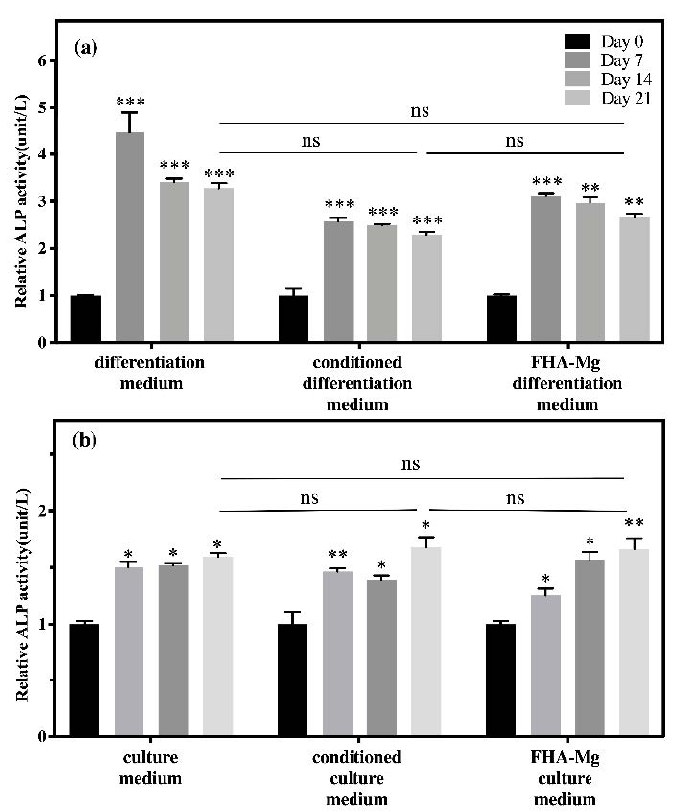
Figure 7. Alkaline phosphatase (ALP) activity of hMSCs cultured on culture dishes (left and middle column groups) and FHA-Mg scaffolds (right column group) in ( a ) osteogenic induction media and ( b ) culture media at 0, 7, 14, and 21 days. The relative ALP activities under various conditions were normalized to that at day 0. Conditioned differentiation or culture media used in this experiment were collected from the FHA-Mg sample incubation in constantly replenished fresh media once every 3 days over a 21-day period. Values shown are mean ± standard error ( n = 3). * p < 0.05, ** p < 0.01, *** p < 0.001 as compared to day 0. N.S.: no significant difference between groups at day